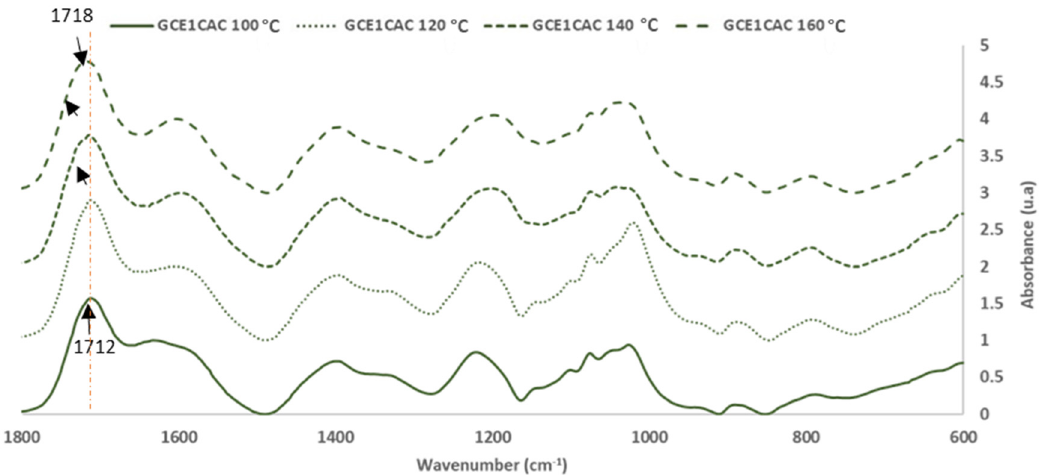
Figure 9. FTIR spectra: Citric acid and Grape cane extract GC E1 cured with citric acid (43% on adhe ‐ sive weight, dry basis) at 100–180 °C (400–4000 cm − 1 ).